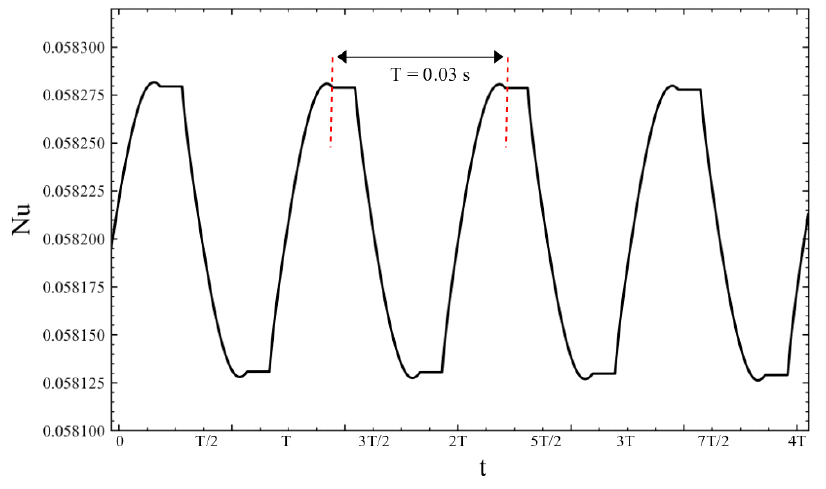
Figure 6. Time variation of the integrated Nu over the cylinder.